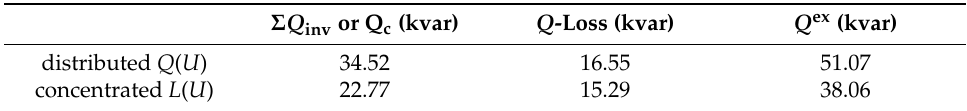
Table 1. Reactive power consumption, loss, and exchange for different control strategies in the LV test grid.